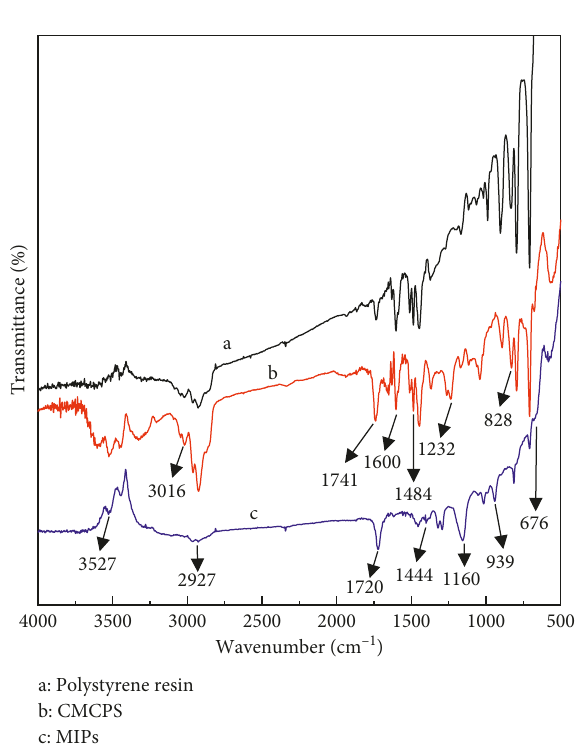
Figure 3: FT-IR spectra of polystyrene resin (a), CMCPS (b), and MIPs